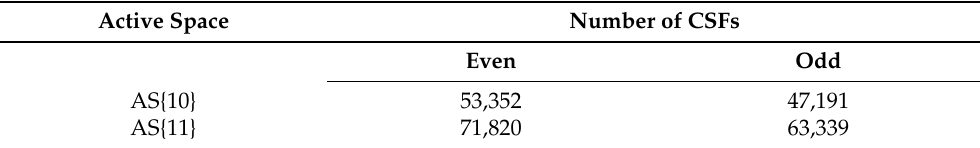
Table 1. The number of CSFs generated for each AS considering the CV correlations for Ar 7 + , Kr 25 + and Xe 43 +